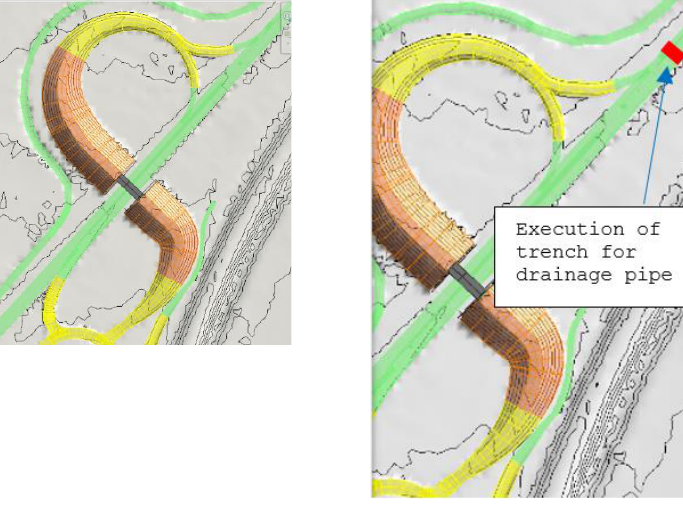
Figure 7. ( Left ): Execution of filters in the risk assessment of the risk of falling to different levels during the execution of the bituminous road surface work unit. ( Right ): execution of a trench for the placement of a drainage pipe.